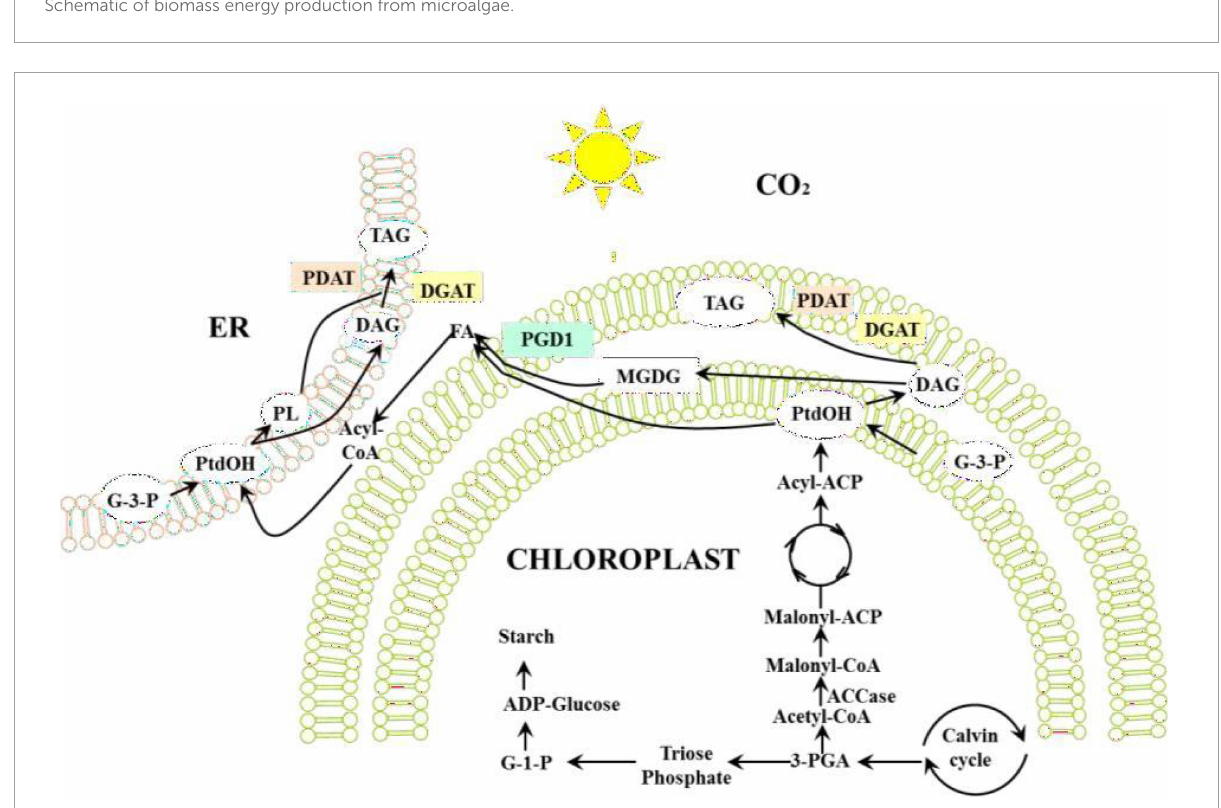
FIGURE5 Triacylglyceride (TAG) synthetic pathway in microalgae cell (Zienkiewicz et al., 2016).